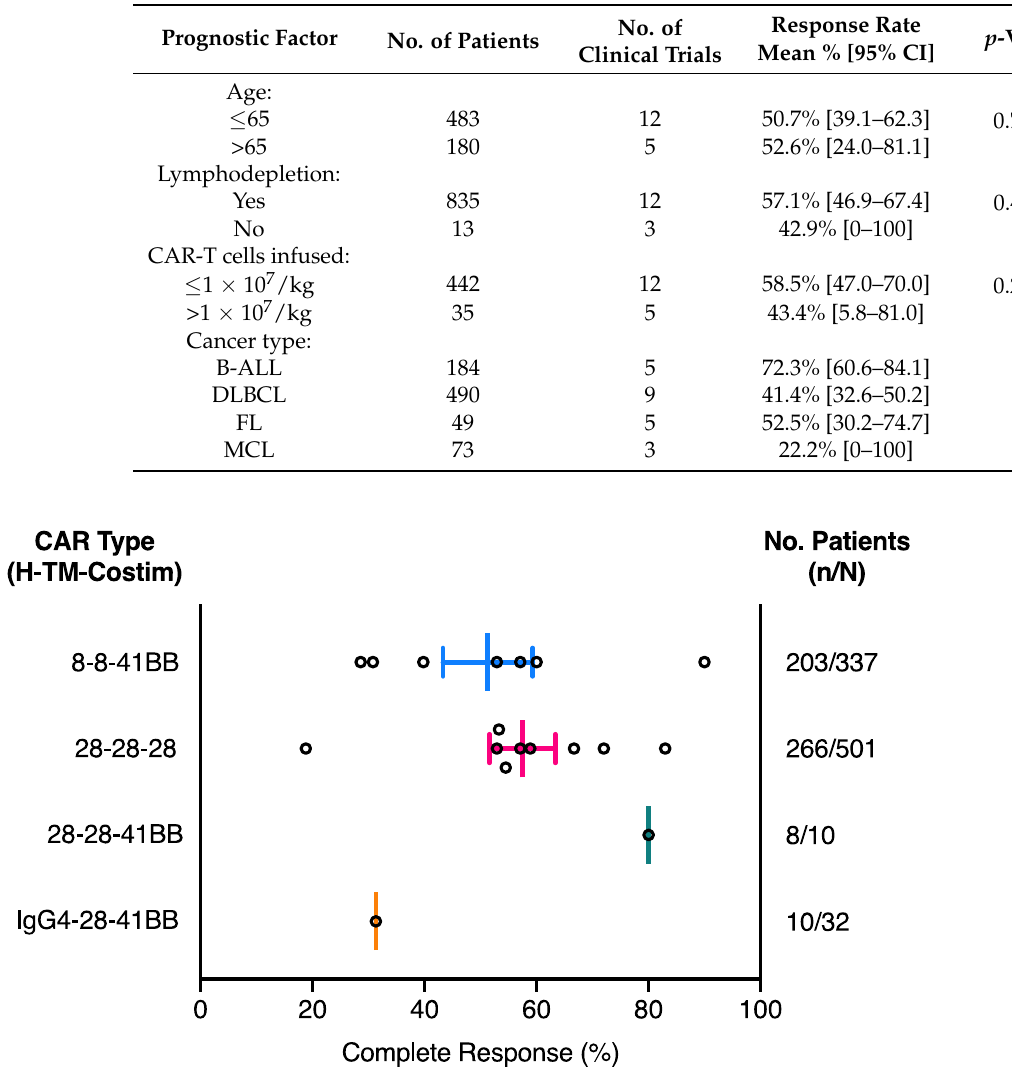
Table 2. Effect of prognostic factors on complete response rate.